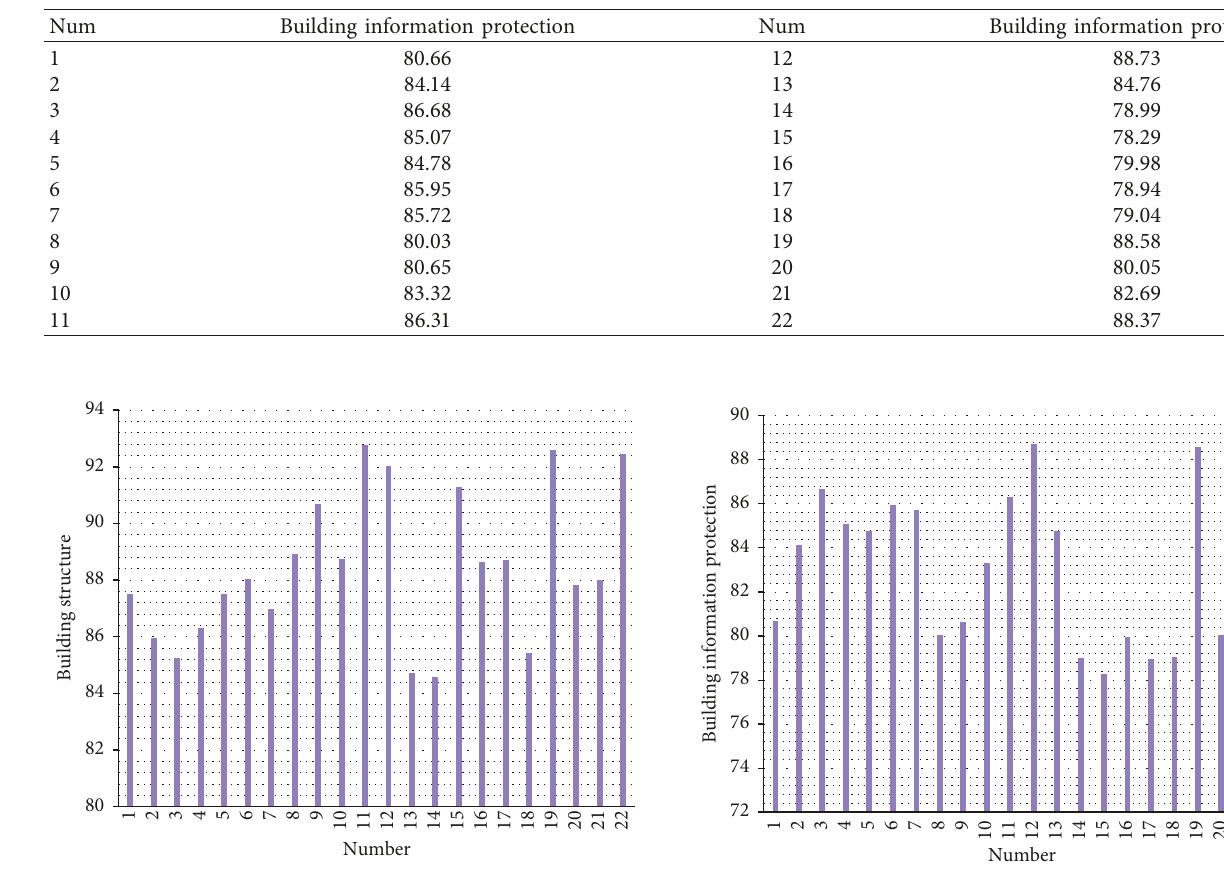
Figure 10: Statistical diagram of the evaluation of the effect of building information protection methods for urban historical features based on BIM